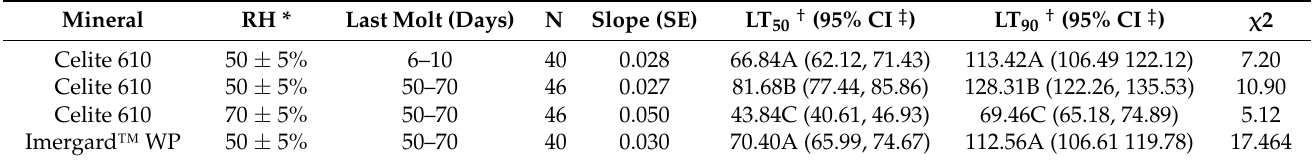
Table 1. Probit model, LT 50 and LT 90 of Ixodes scapularis unfed nymphs exposed by dipping into Celite 610 and